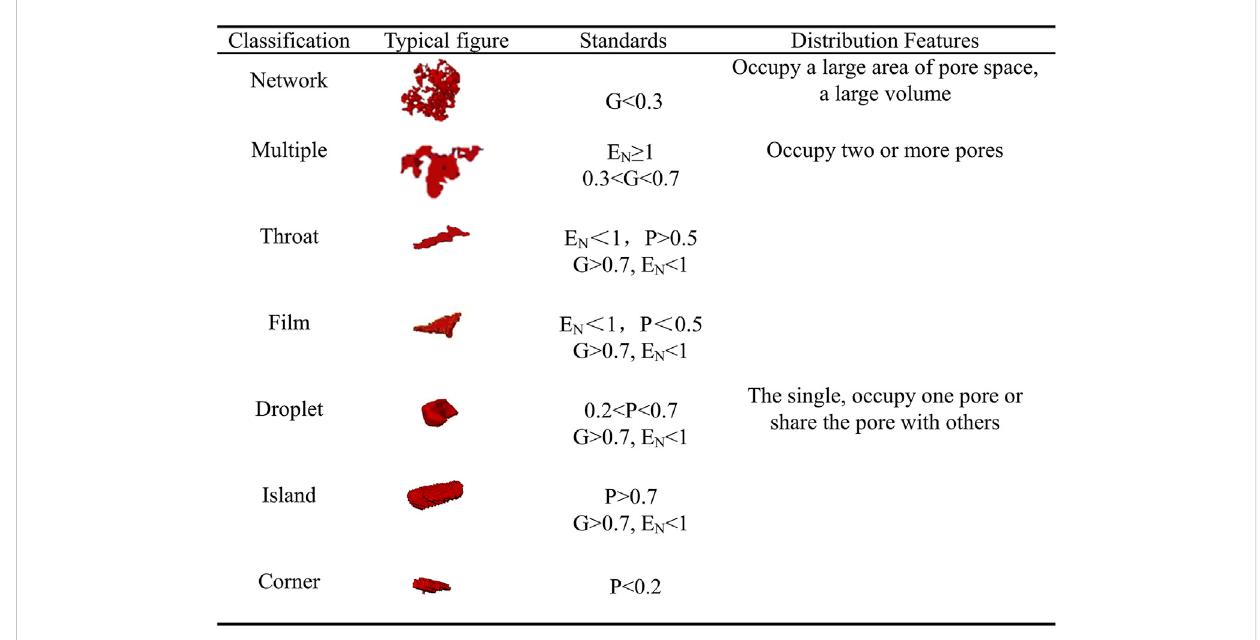
FIGURE 3 Quantitative characterization of micro-remaining oil.